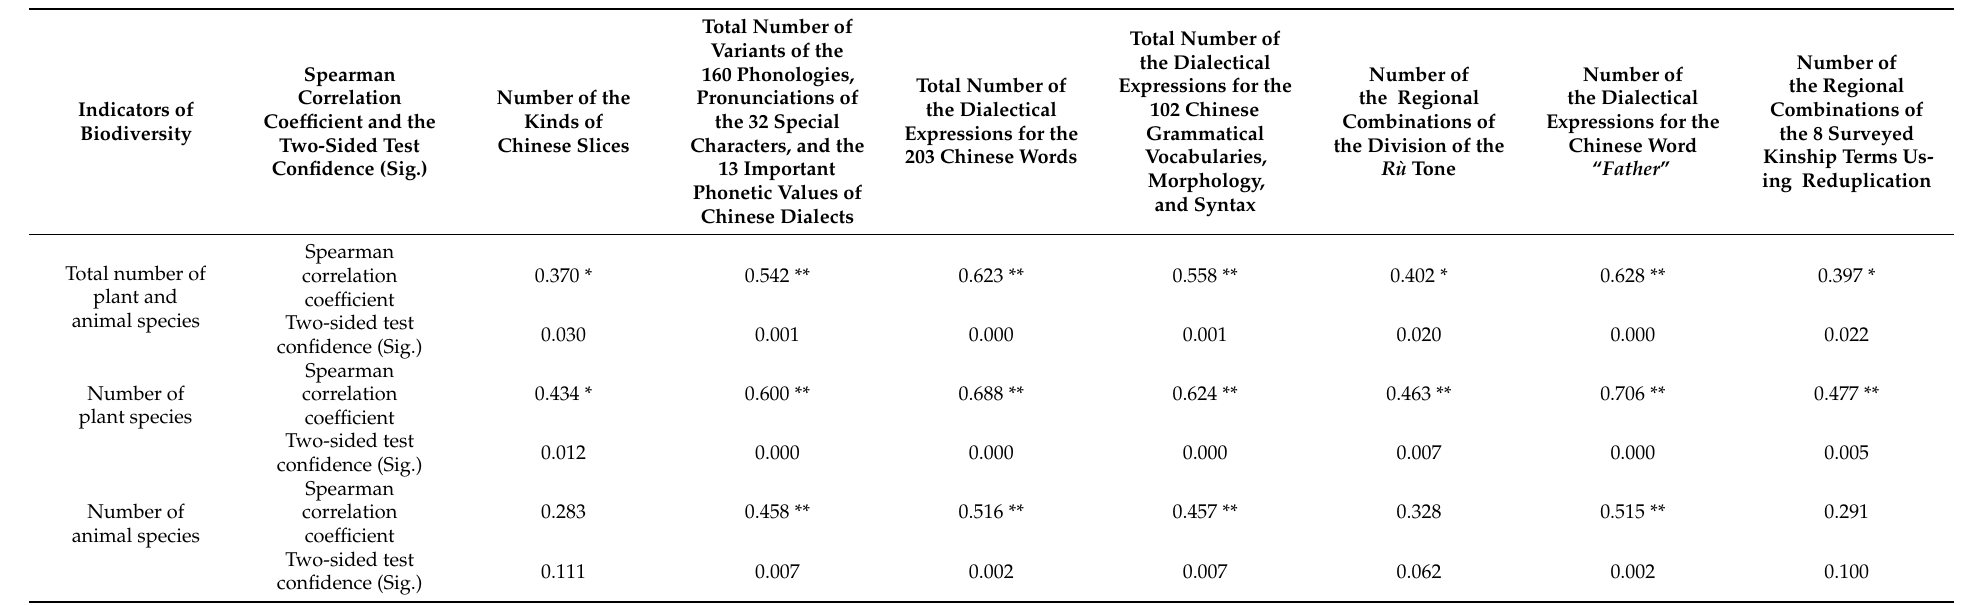
Table 3. Spearman correlation coefficients of biodiversity with the diversity of minority languages and the diversity of Chinese dialects in China.